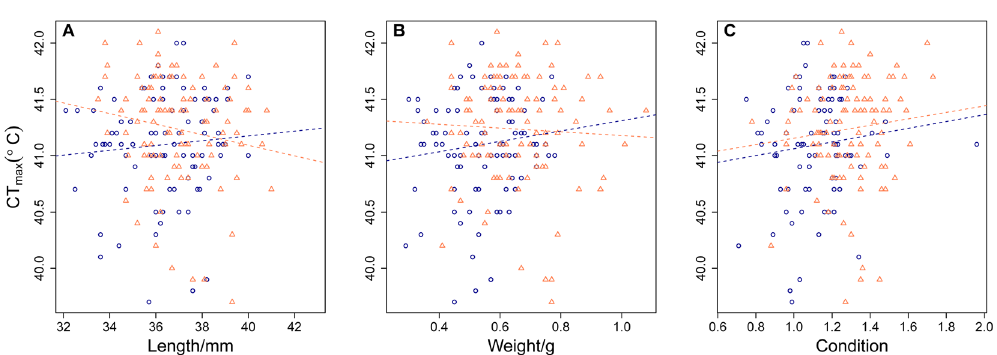
Figure 4. Relationship between CT max and three size metrics: ( A ) Length, males: F = 0.59 1,86 , p = 0.45, R 2 = 0.01, females: F = 2.88 1,86 , p = 0.09, R 2 = 0.03. ( B ) Weight, males: F = 1.22 1,88 , p = 0.29, R 2 = 0.01, females: F = 0.24 1,102 , p = 0.62, R 2 = 0.01. ( C ) Condition index, males: F = 1.11 1,86 , p = 0.29, R 2 = 0.01, females: F = 1.12 1,102 , p = 0.29, R 2 = 0.01. Females are shown by orange triangles and males by blue